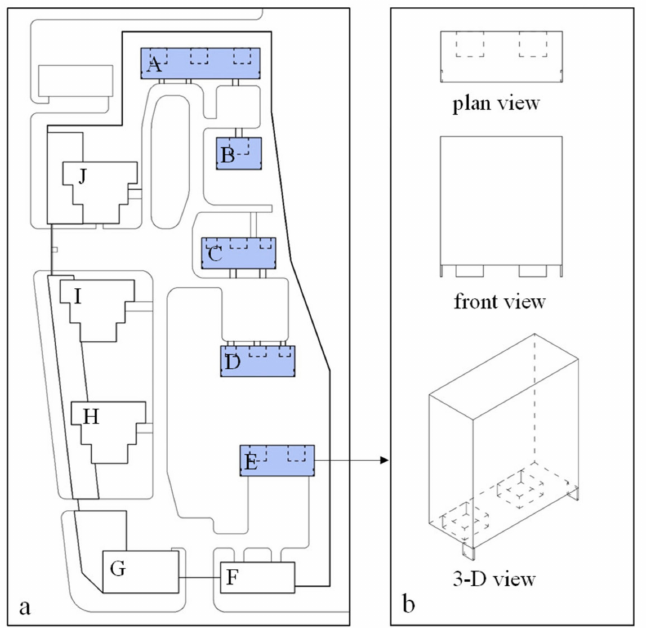
Figure 6. Schematic diagram of lift-up buildings: ( a ) The locations of the lift-up areas and the vertical structural elements, ( b ) schematic diagrams of the lift-up building